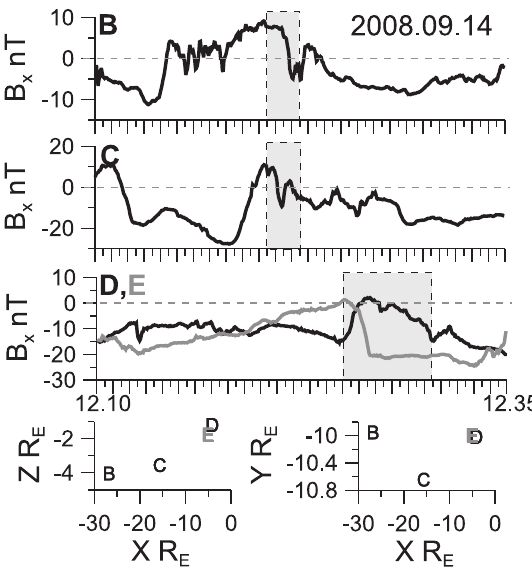
Fig. 1. Example of B x component of the magnetic field measured by four spacecraft. Also spacecraft positions are